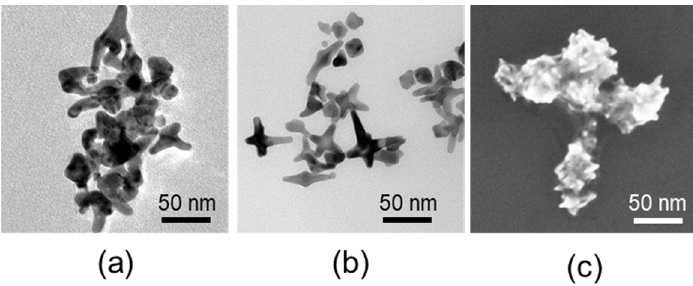
Figure 4. ( a ) TEM images of GNS; ( b ) TEM images of GNS-PEG; ( c ) SEM images of GNS.